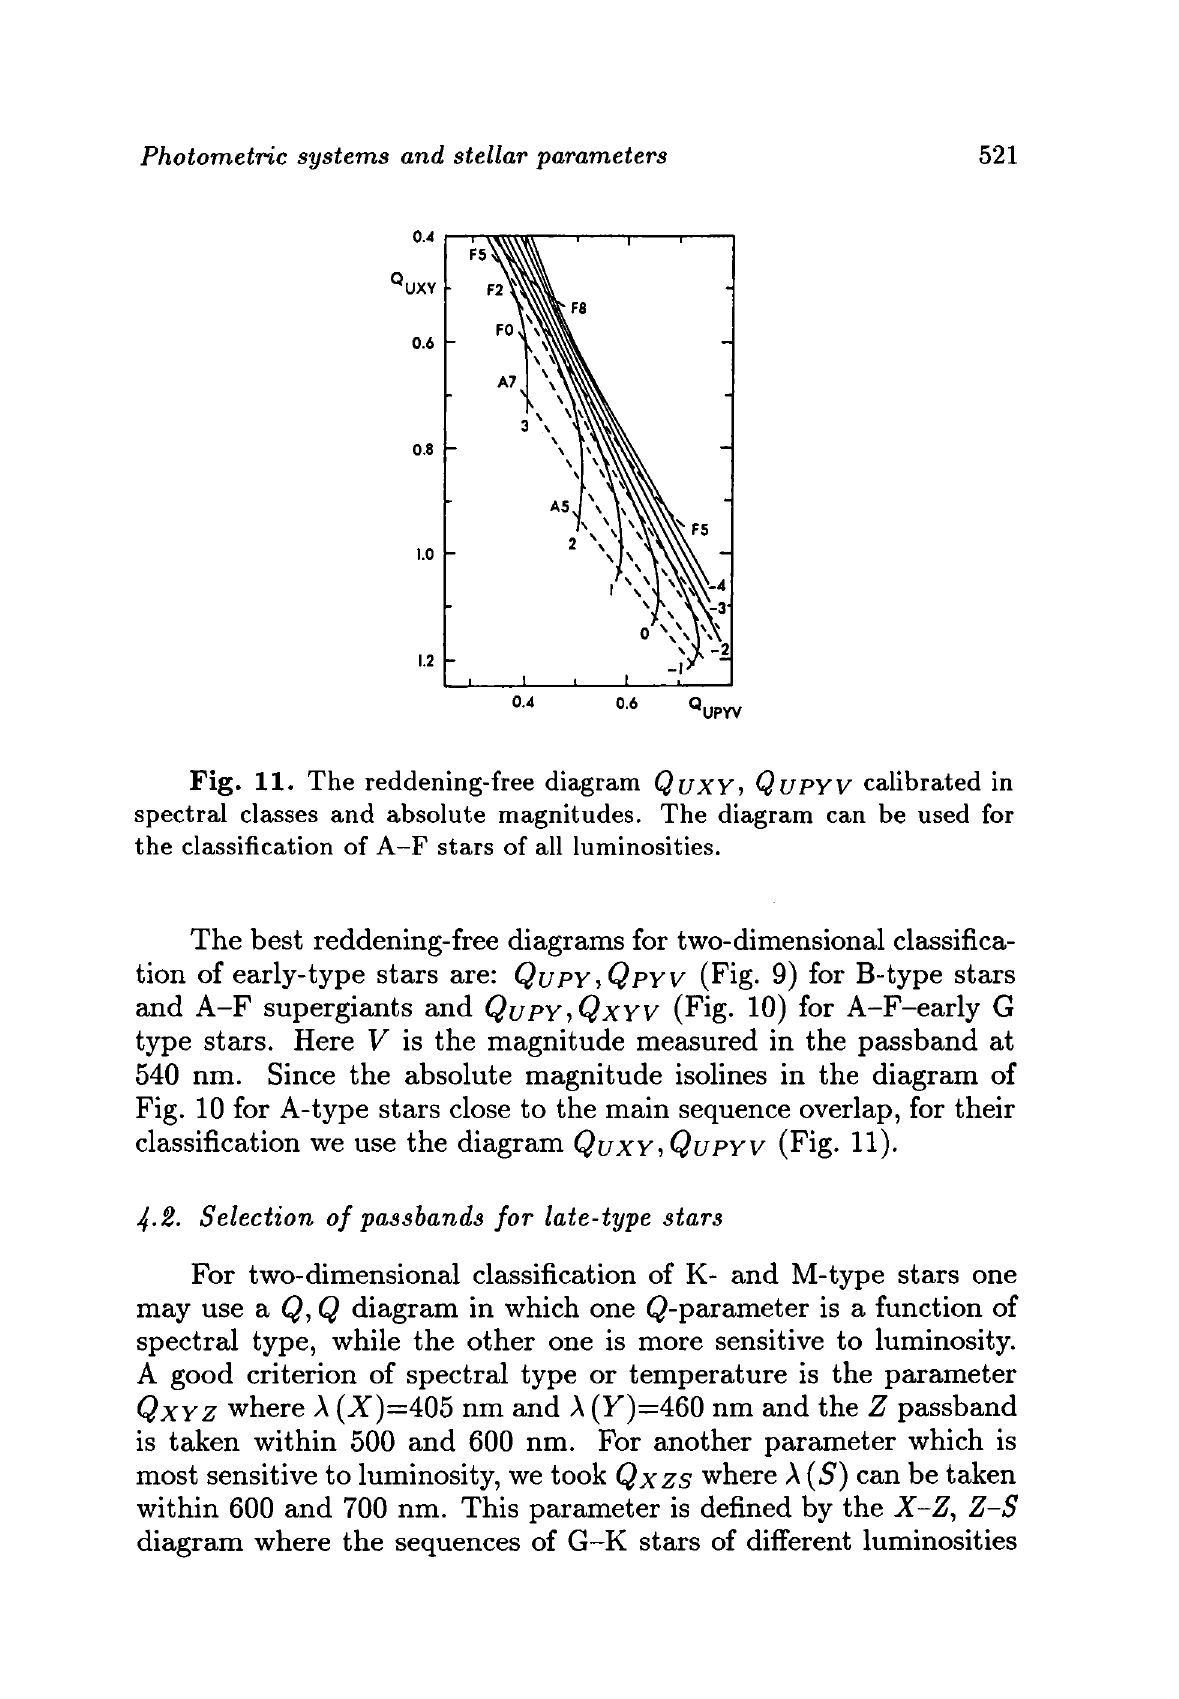
Fig. 11. The reddening-free diagram QUXY, QUPYV calibrated in spectral classes and absolute magnitudes. The diagram can be used for the classification of A-F stars of all luminosities.